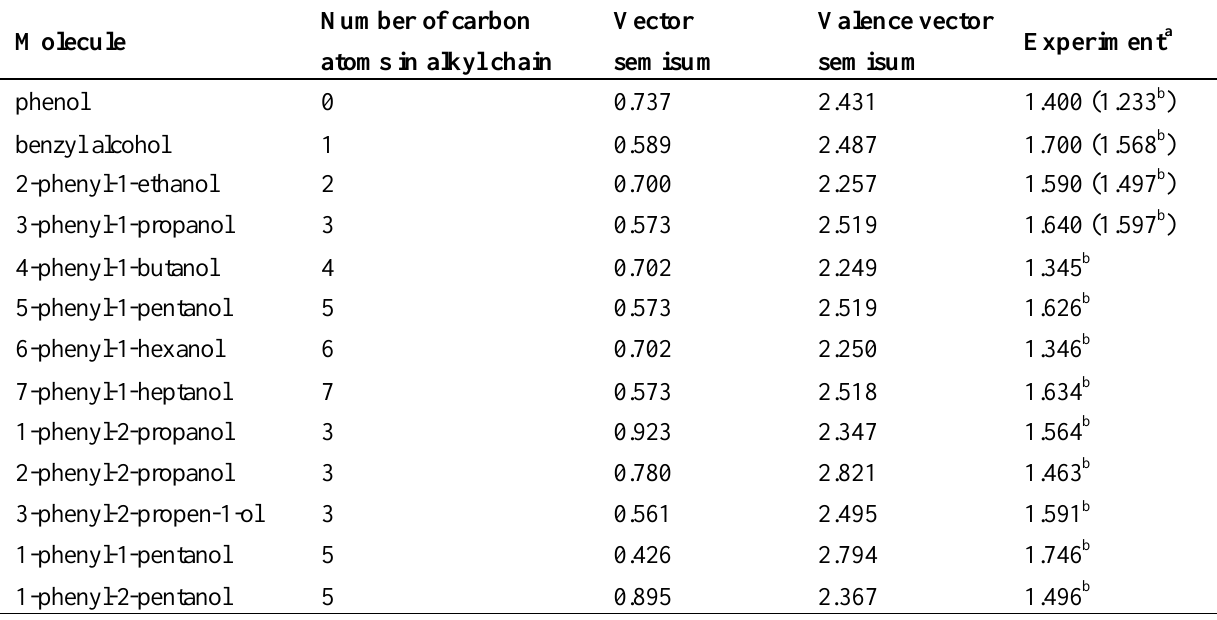
Table 2. Molecular dipole moment values, m (D), for a series of phenyl alcohols with charge-transfer